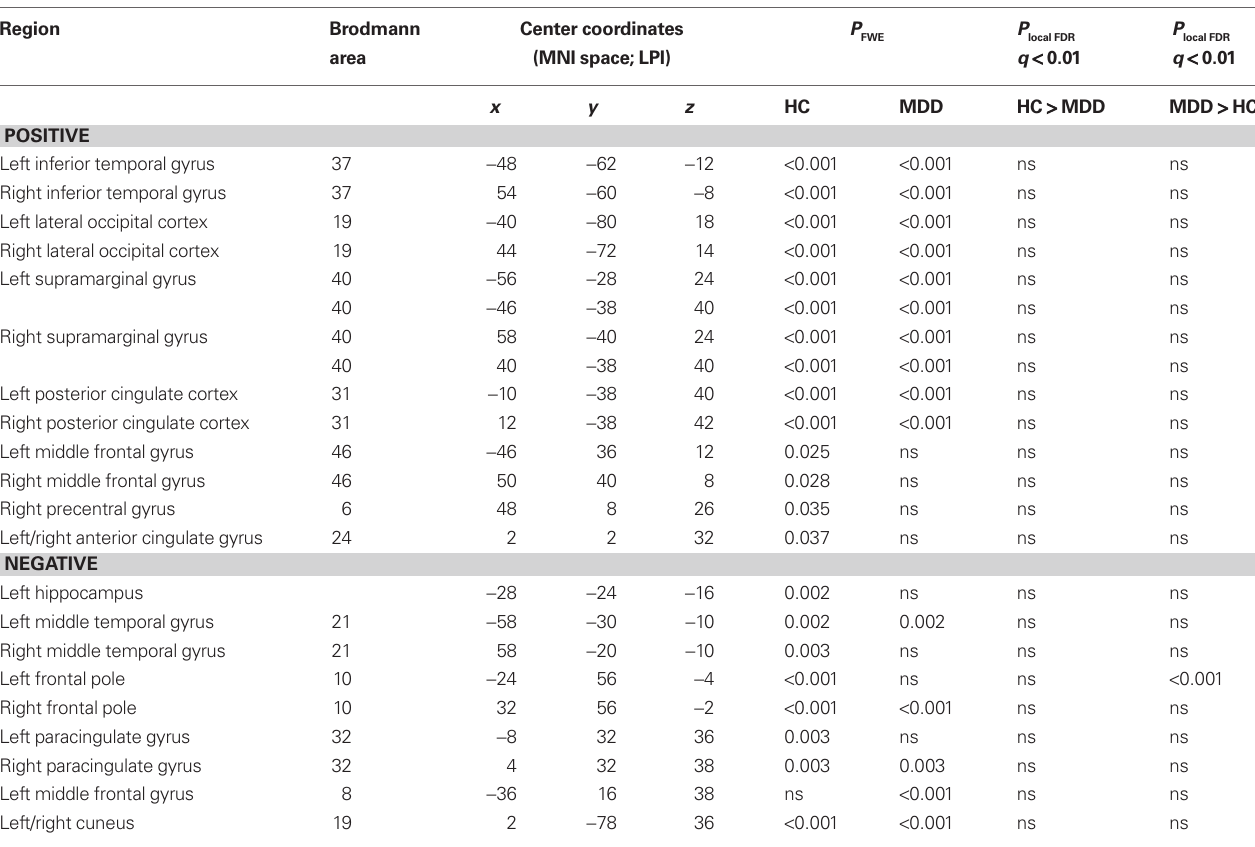
Table 3 | rSN 11 characteristics and statistics. region